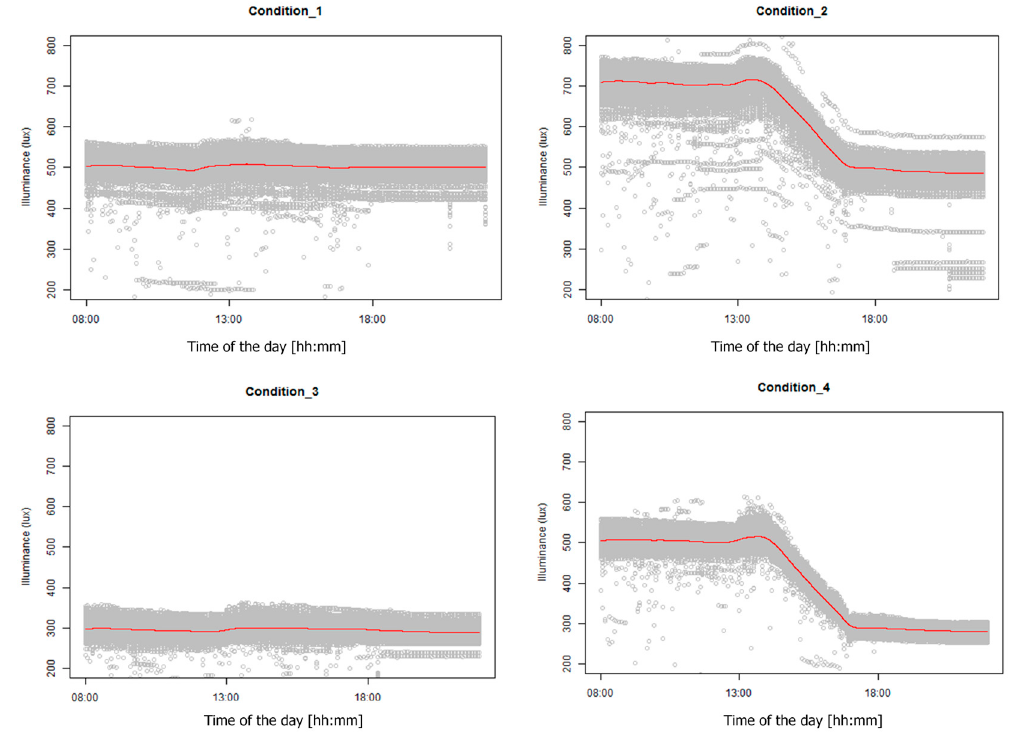
Figure 8. Daily temporal illuminance variations in all lighting conditions (Condition_1: JP-T;